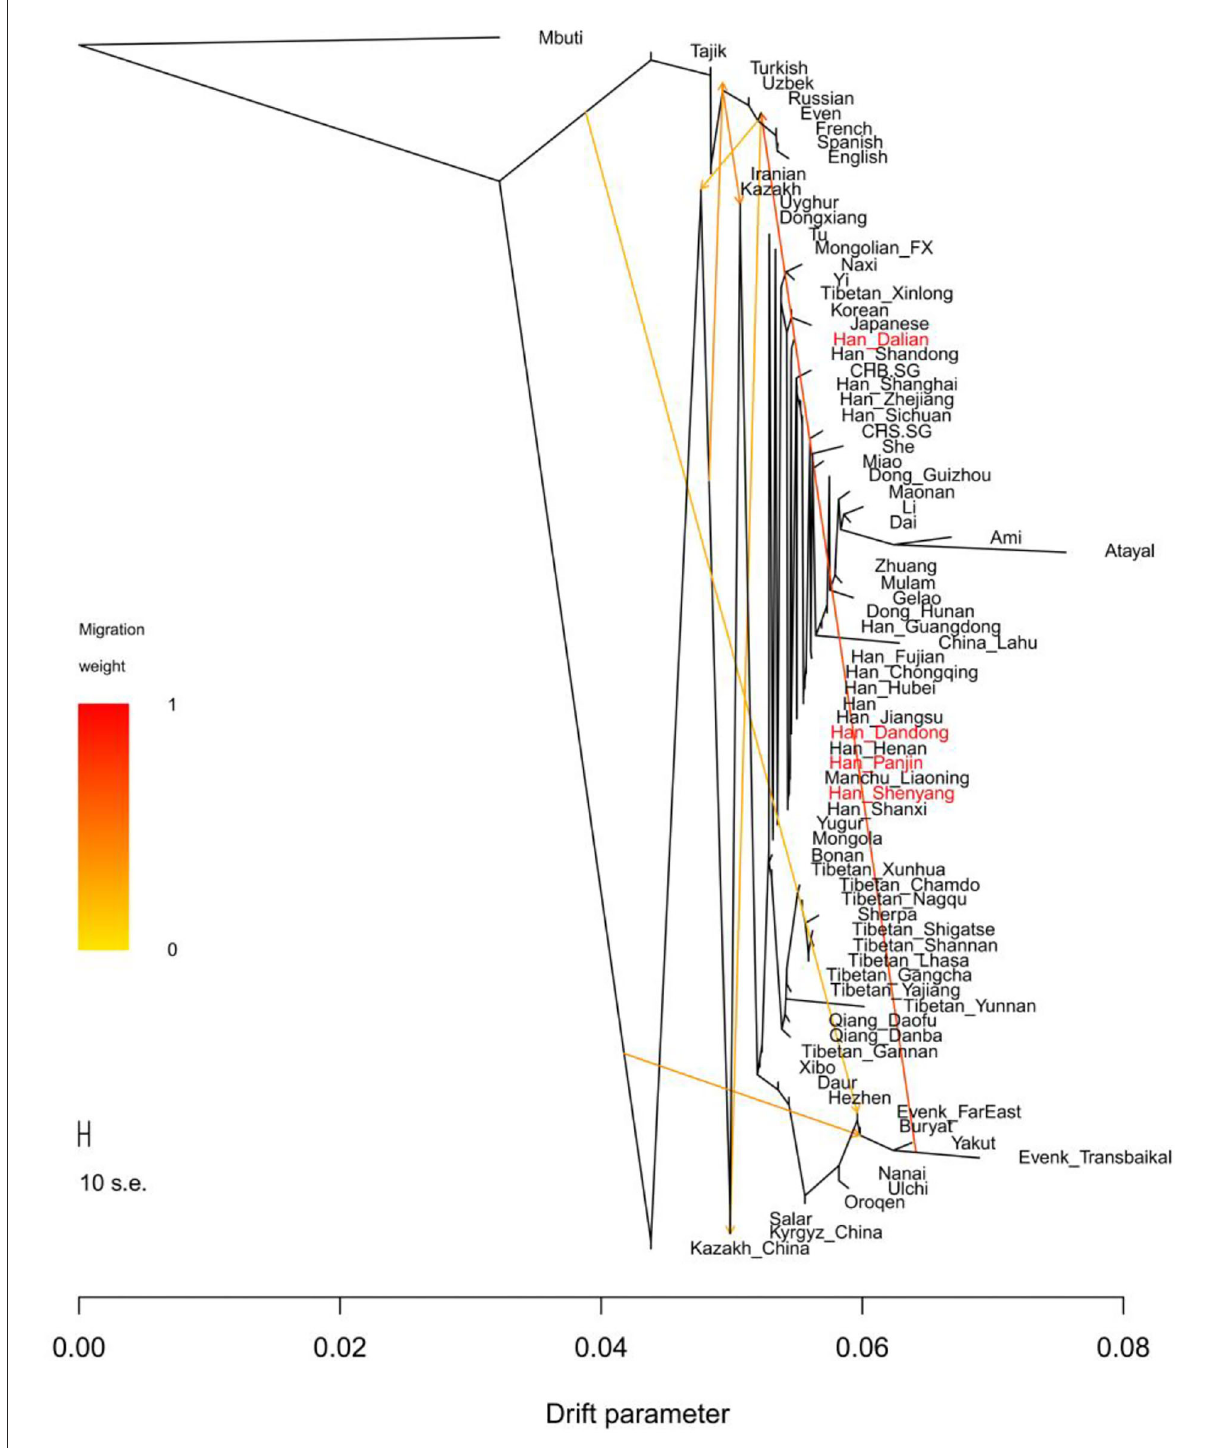
FIGURE10 TreeMix-based maximum-likelihood phylogenetic tree with seven migration events among Eurasian